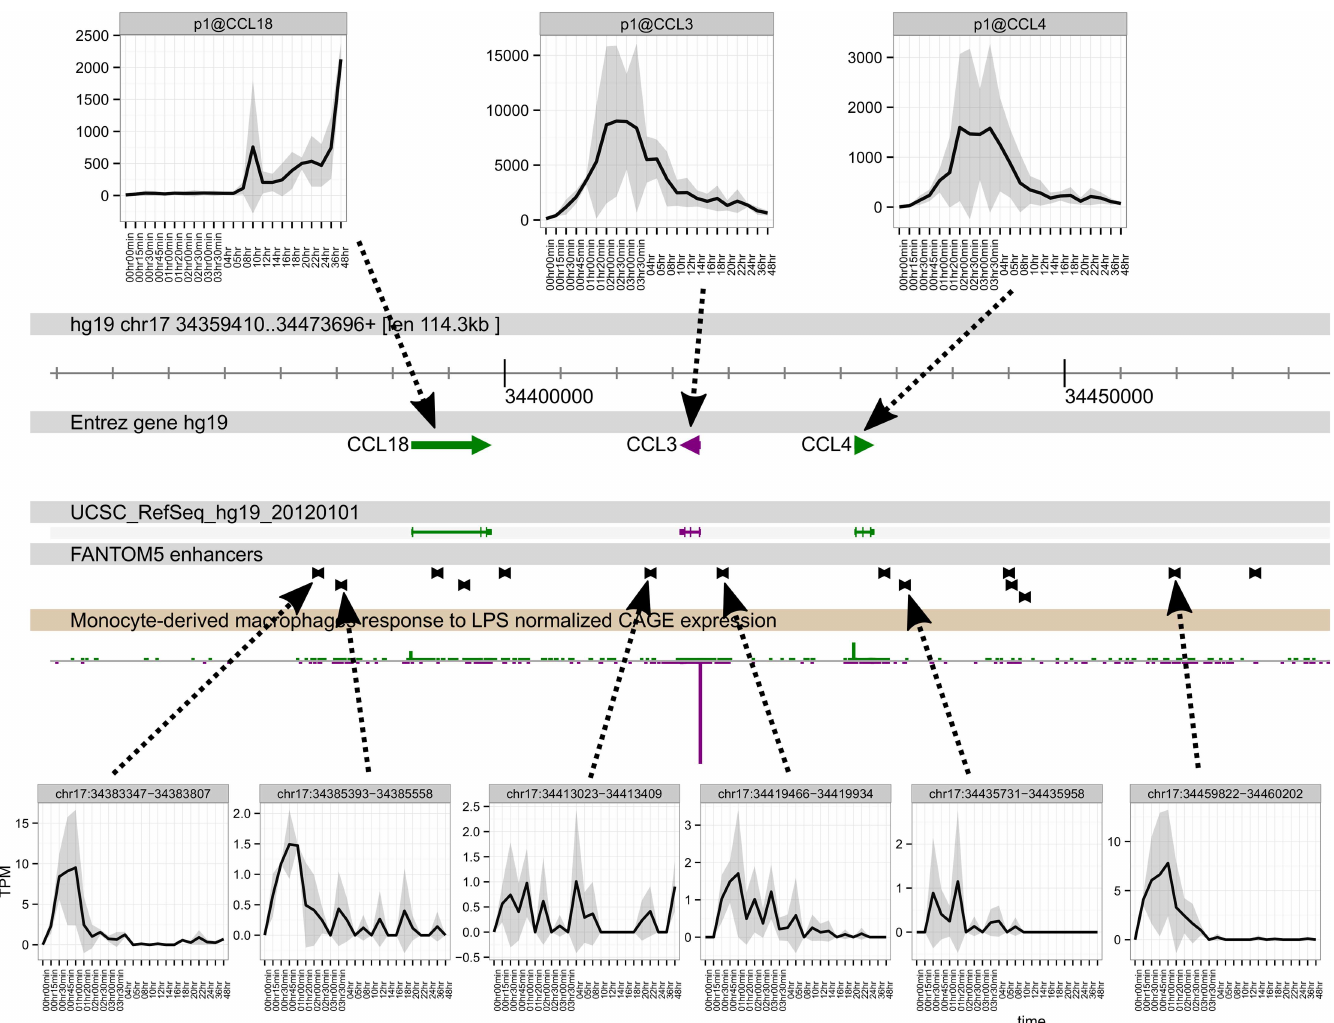
Fig 4. The time course of activation of enhancers and promoters at the CCL3/CLL4/CCL18 locus. The core panelshows a genomebrowserview of the locuswith the locations of FANTOM5 enhancers.The upper panelshow the time course of inductionof eachof the mRNAs, detected by CAGE. Whereas CCL3 and CCL4 are coordinately-regulated, CCL18 followsa much slowertime course and is still rising at 48 hours. The lower panelsshow the activity of the enhancers indicated.The lowesttrack shows the histogramsof CAGE tags mappedto the region,with colours indicatingdirectionof transcription; green to the right and purpleto the left. Note that the entire regionsshows evidenceof bidirectional transcription initiation.Data are expressed as TPM, andare the averageof the three